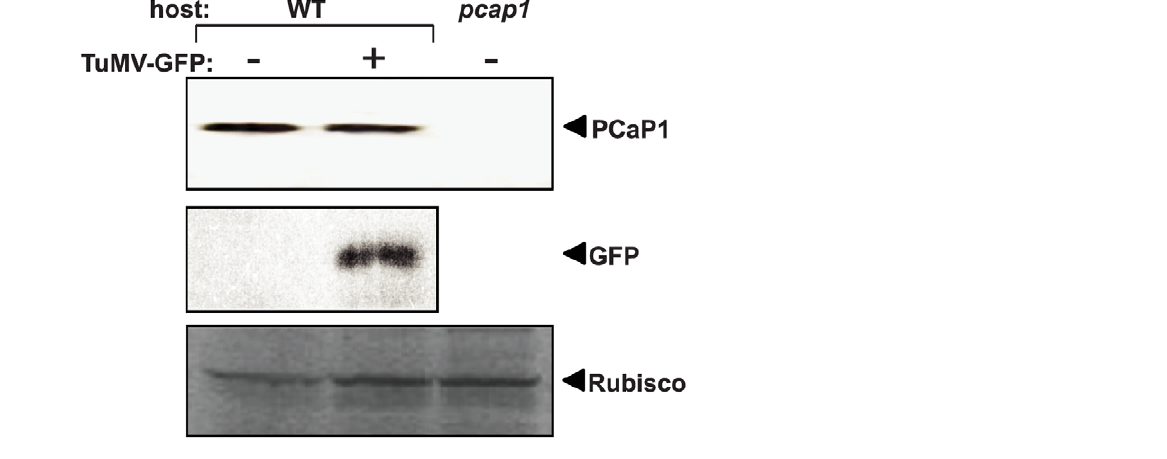
Figure 6. Immunodetection of PCaP1 in wild-type and PCaP1 knockout Arabidopsis plants. Total soluble proteins from leaves collected at 14 dpi were separated by 4–12% Novex Tris-glycine PAGE, blotted onto PVDF membrane, probed with anti-PCaP1 antibody or anti-GFP antibody and detected by ECL-Plus Western reagents. Samples were from mock inoculated or TuMV-GFP infected wild-type (WT) or PCaP1 knockout ( pcap1 ) plants. Equal loading of proteins was verified by similar levels of Coomassie staining of Rubisco protein (bottom